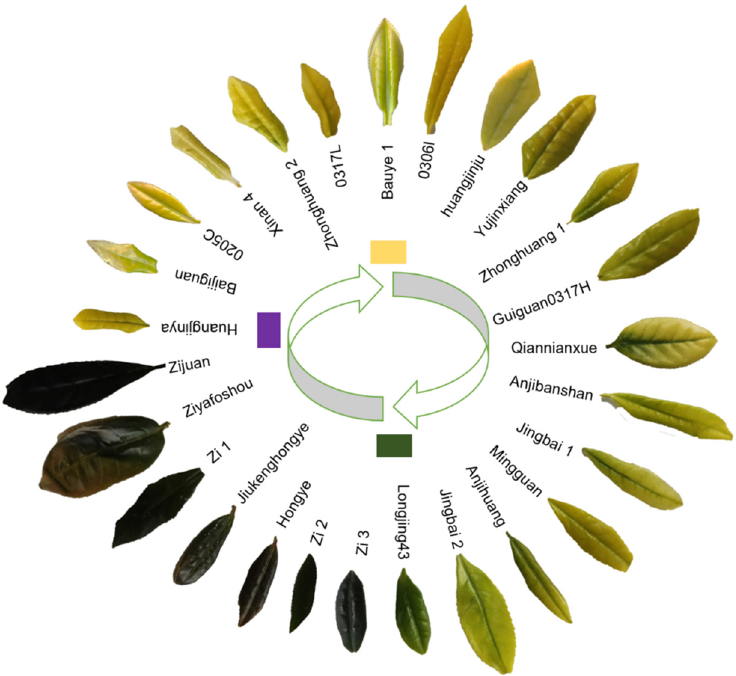
Figure 1. Leaf color and morphology of 26 tea cultivars at the one-bud, two-leaf stage. ‘Baijiguan’ was not collected at the same time as other cultivars because its germination was significantly later than the others’.